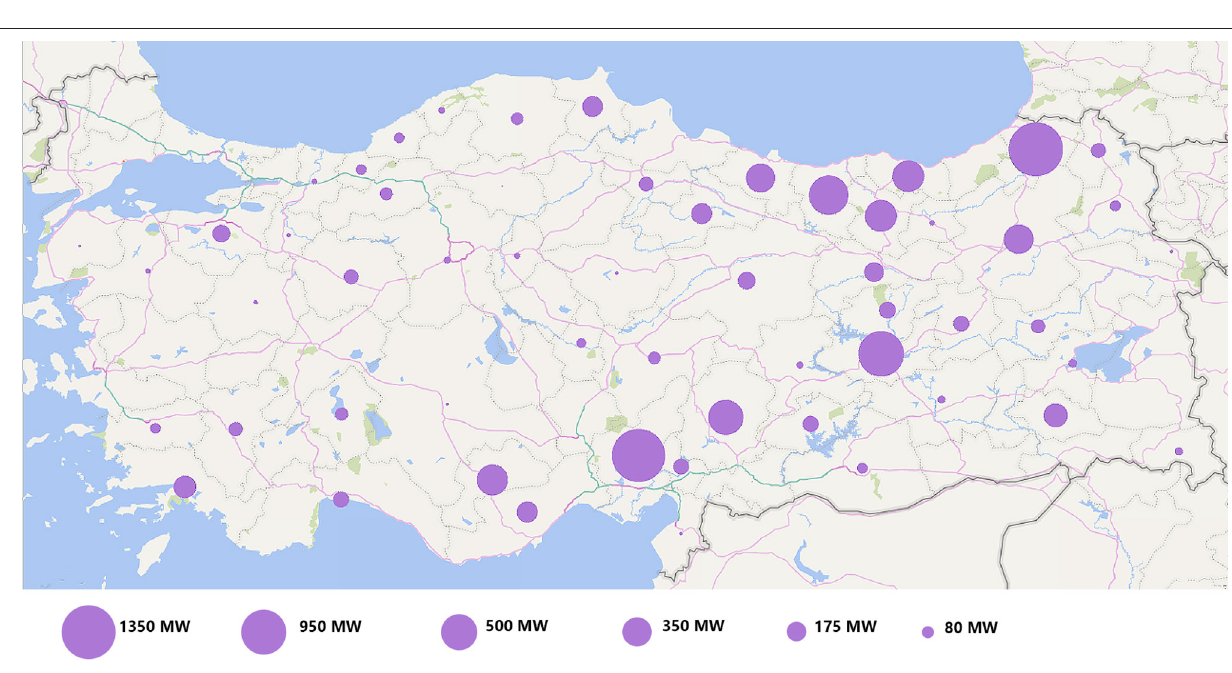
FIGURE 7 | Distribution of the newly installed capacity of HPPs below 10 MW between 2003 and 2018, in the cities Source: Own elaboration using data from MENR 17